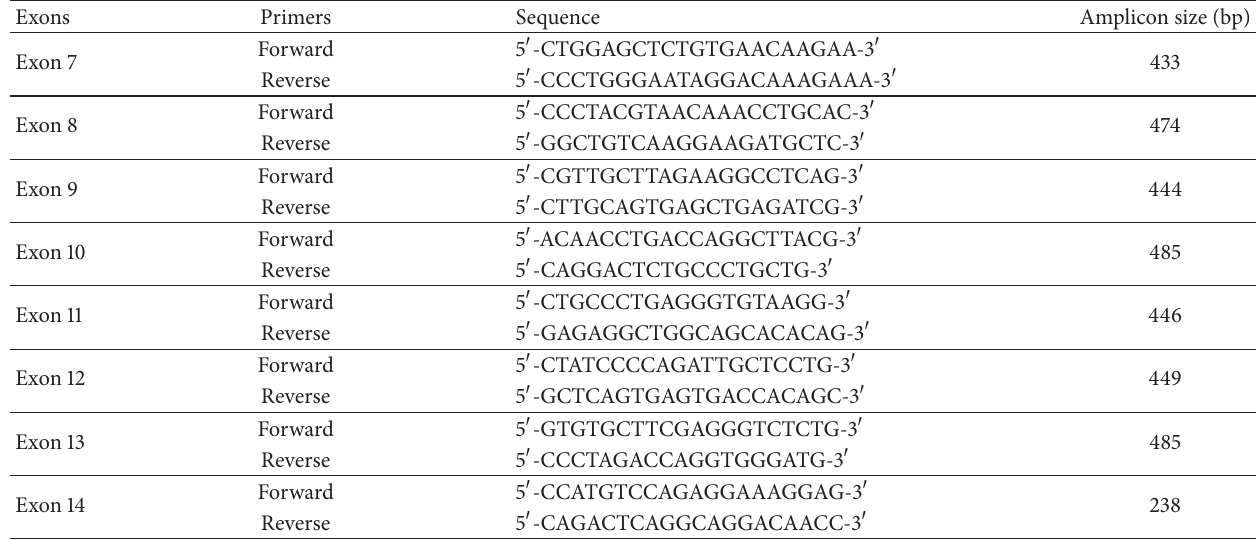
Table 1: Primer sequence used to screen the different exons of TPO